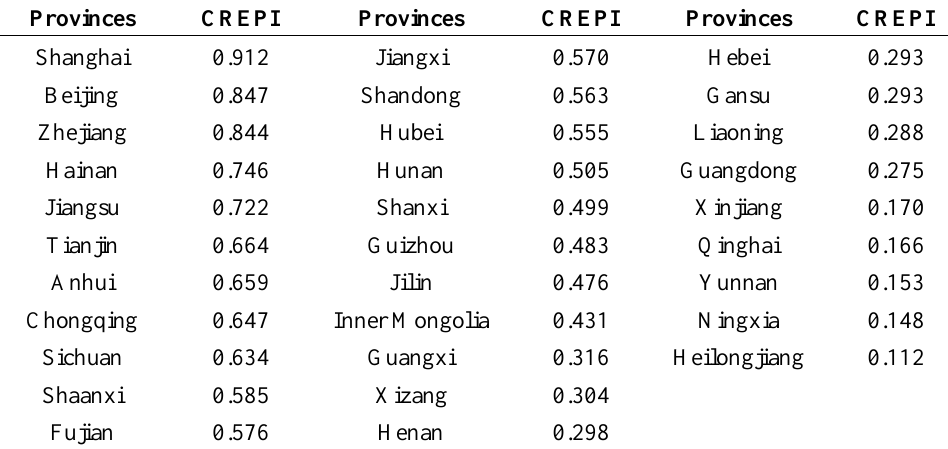
Table 5. Provincial CREPI during study period in